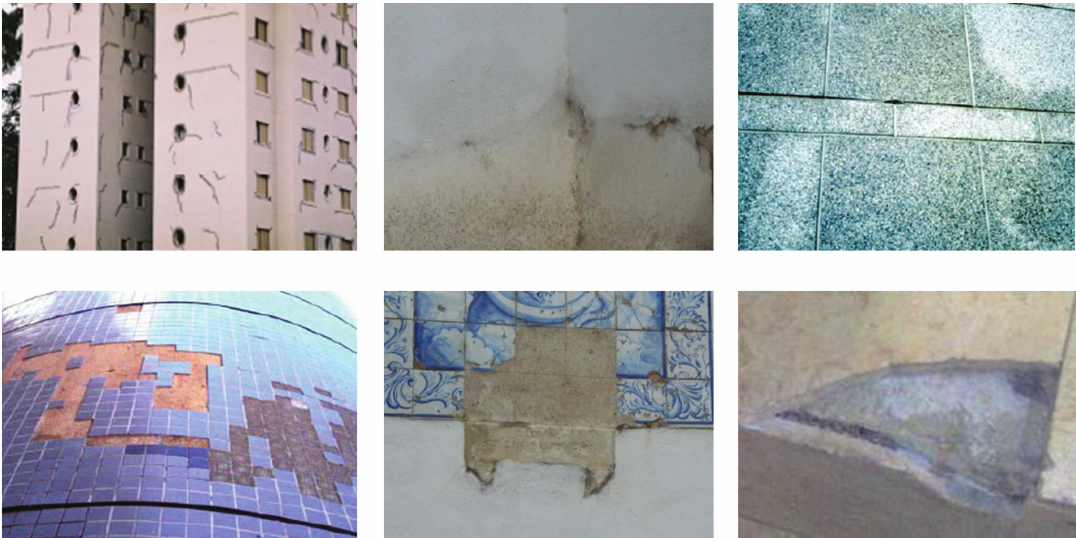
Figure 9: Di ff erent types of materials applied as fac¸ade coatings and some